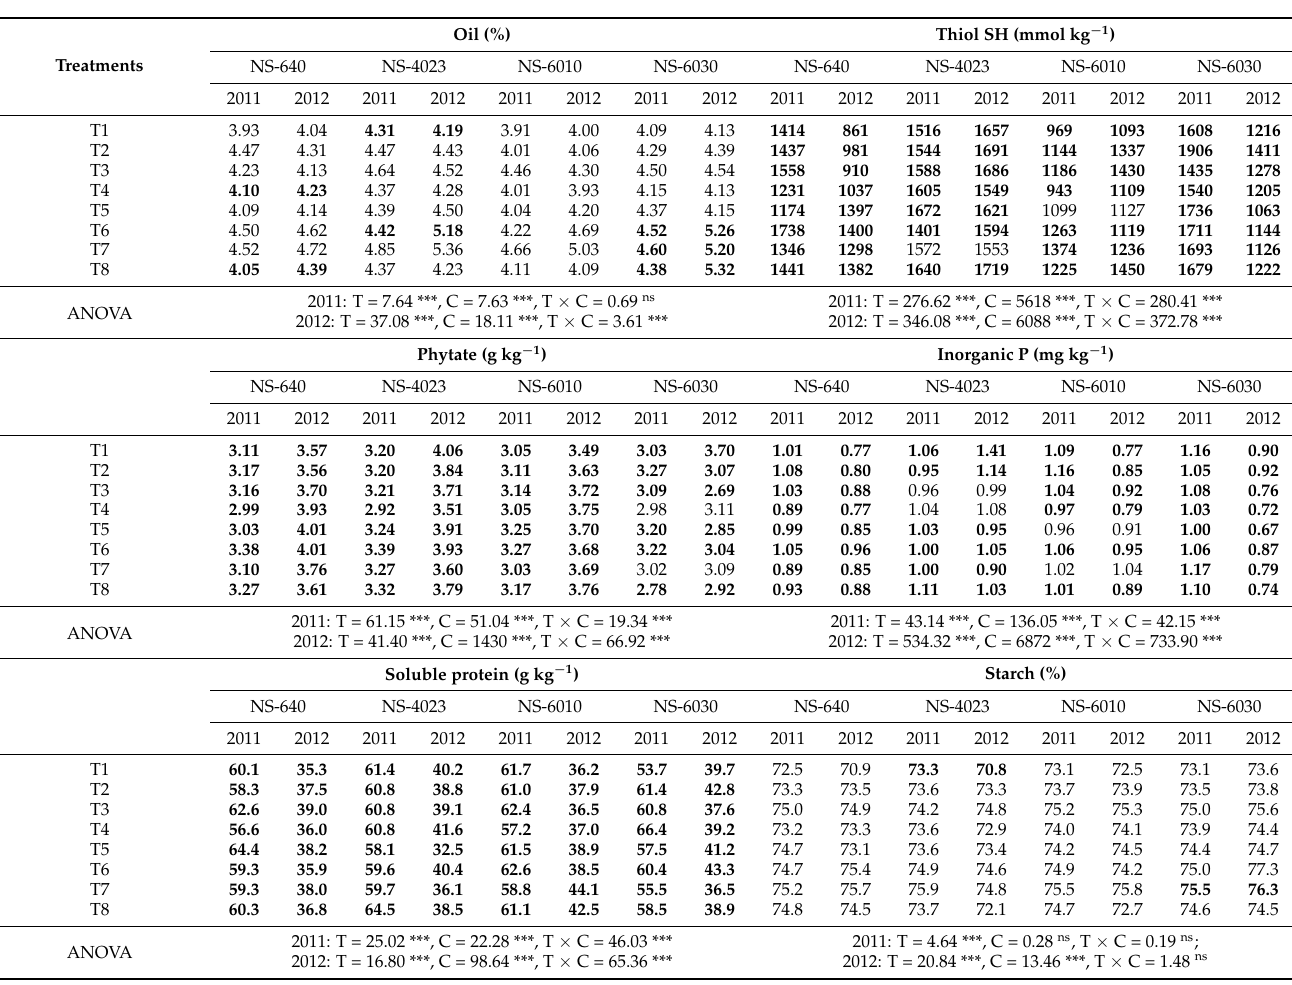
Table 3. Fertilization effects on grain oil, thiol SH, phytate, inorganic phosphorus, soluble protein and starch contents of four maize cultivars over two